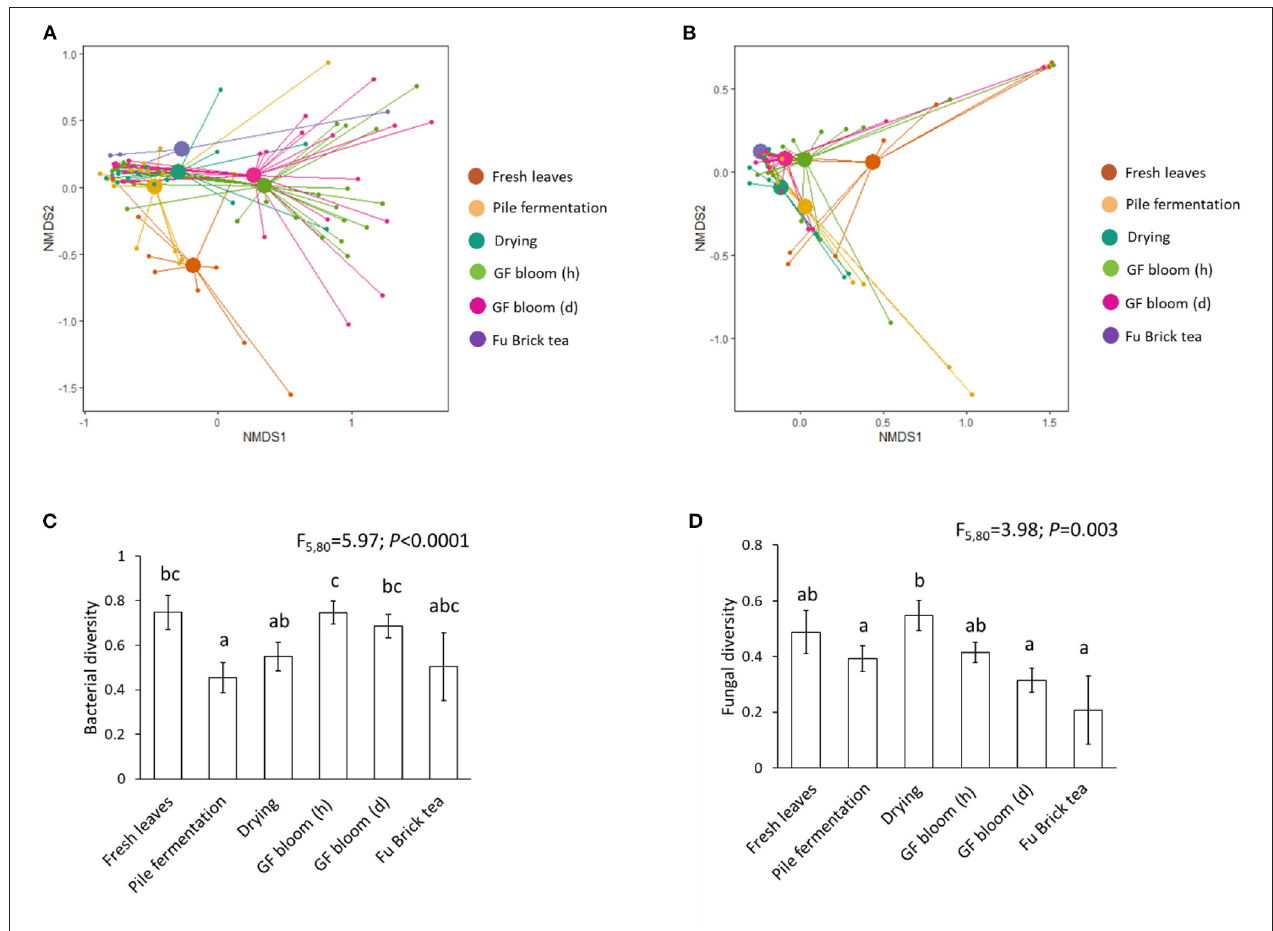
FIGURE 2 | Assessing microbial diversity at different stages of the Fu Brick manufacturing process. Non-metric Multidimensional Scaling (NMDS) plots with Bray-Curtis dissimilarity distances for bacterial (A) and fungal (B) communities, and bar plots showing statistical results following linear mixed models for bacterial (C) and fungal (D) diversity. Standard errors from the mean for each stage are shown with each bar, and letters above bars indicate significant differences between manufacturing stages. “GF bloom (h)” is the early stage golden flower bloom and “GF bloom (d)” is the full golden flower bloom.